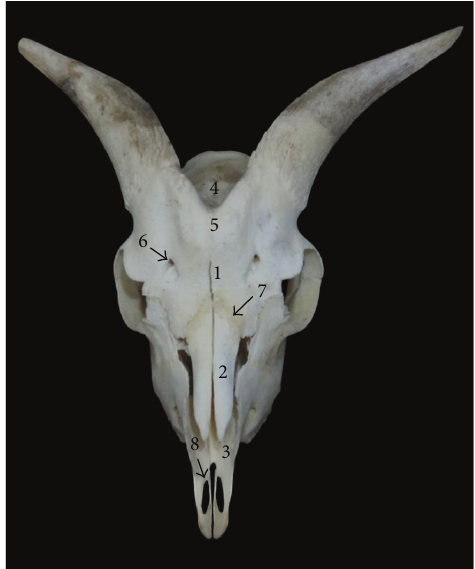
Figure 4: Frontal view of the skull of Markhoz goat showing 1: frontal bone, 2: nasal bone, 3: incisive bone, 4: parietal bone, 5: intercorneal prominence, 6: supraorbital foramen, 7: frontonasal suture, and 8: palatine fissure.